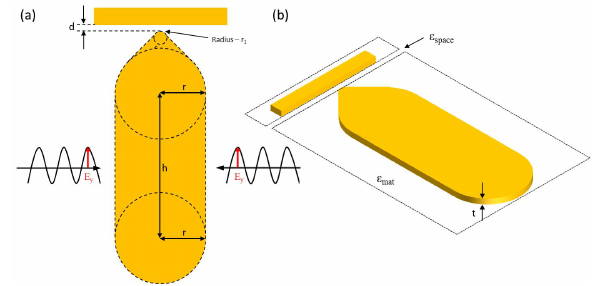
Figure 3: Droplet transducer design excited by two beams in a MZI- coupling arrangement. (a) Top view of the droplet transducer with the image plane of the recording medium, and (b) 3D view of the transducer embedded in a material with permittivity ε mat . The ma- terial between the transducer and the image plane was modeled with a material with permittivity ε space = 2. The droplet transducer is composed of disks of radius r and separated by